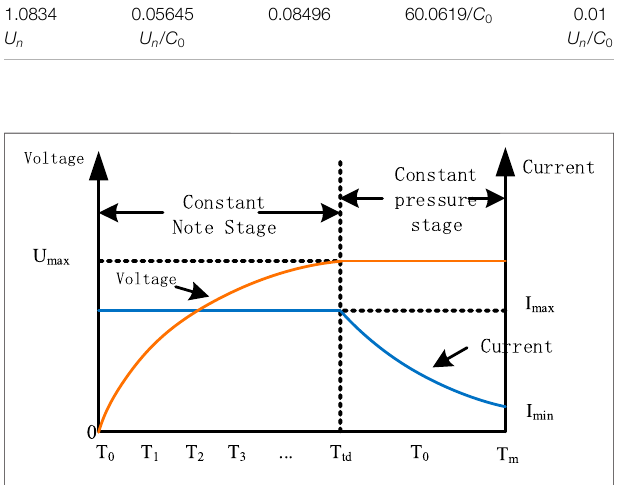
FIGURE 1 | Current and voltage changes in the CC – CV charging mode.